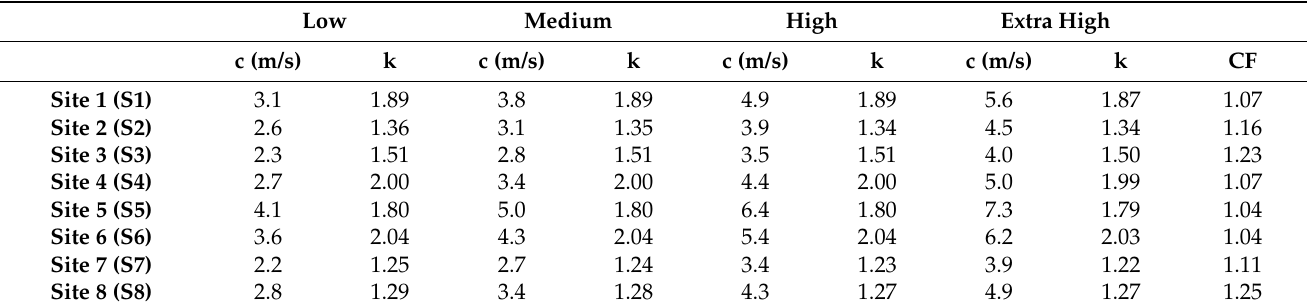
Table 3. Weibull scale factor c and shape factor k for the eight sites considered (data from [35]). Low Medium High Extra High